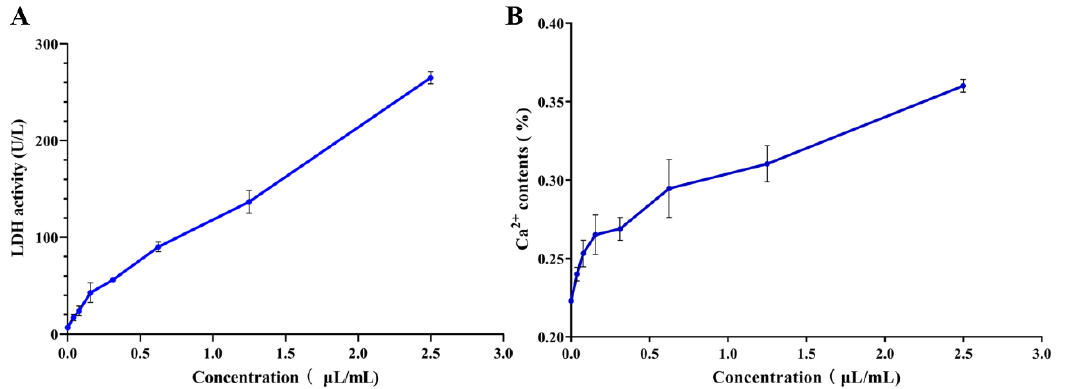
Figure 3. Effects of PEO on cell damage of S. mutan . ( A ) PEO increases LDH activities in the supernatant with the increase of concentration. ( B ) PEO increases the Ca 2+ contents in the supernatant with the increase of concentrations.